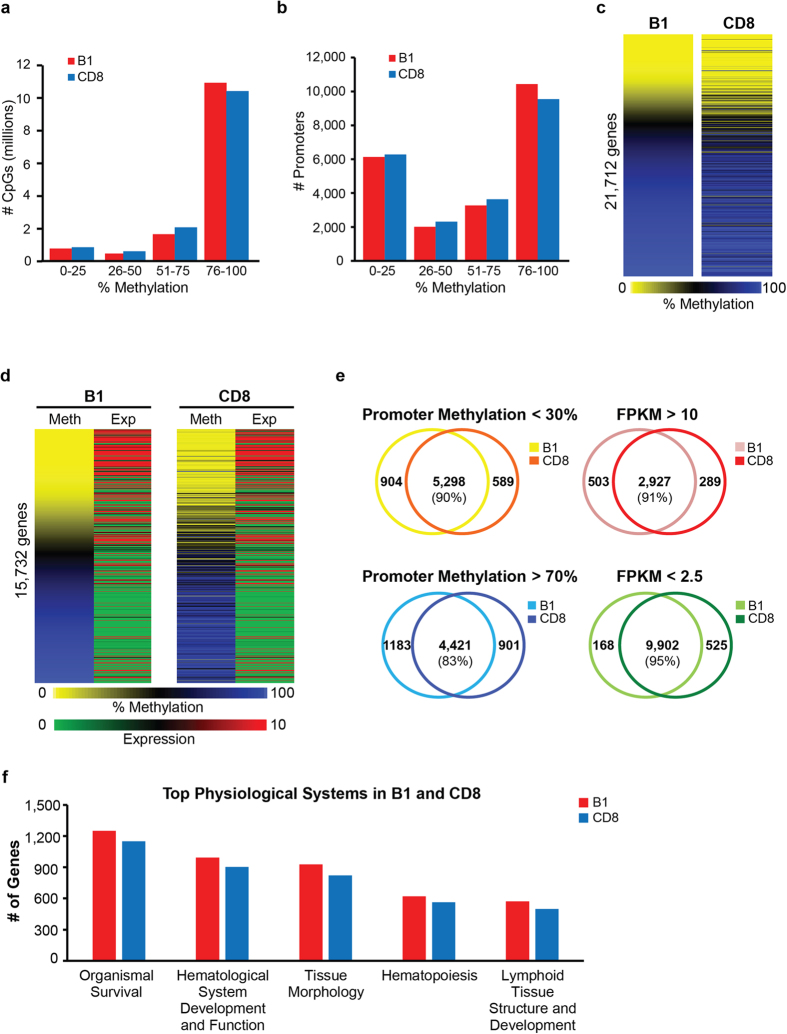
Transcriptome and methylome of normal B-1a and CD8 cells.(a) Breakdown of CpG methylation as determined by WGBS in B-1a (B1) and CD8 samples. Individual CpGs were placed into 4 categories based on percent methylation (0–25%, 26–50%, 51–75%, and 76–100%). (b) Breakdown of promoter methylation for 21,712 genes in B1 and CD8 samples. Methylation percentage for individual CpGs were annotated to the core promoter regions (−300 bp to +150 bp relative to the TSS). Methylation percentages for all CpGs across the 450 bp region were averaged to give a mean methylation value for each gene promoter. Promoters were placed in 4 categories based on percent methylation (0–25%, 26–50%, 51–75%, and 76–100%). (c) Methylation status of 21,712 promoters in B1 and CD8 samples as determined by WGBS. Mean promoter methylation was determined as described in part b of the figure legend. Hypomethylation is shown in yellow and hypermethylation in blue. (d) Heat map presentation of promoter methylation (analyzed as in Fig. 2b) and corresponding gene expression (presented as average FPKM values as determined by RNA-seq) in mouse splenic B1 and CD8 cells for 15,732 genes. Genes with high FPKM values are shown in red and genes with low FPKM values are shown in green. Heat maps are organized in the same gene order to match data for methylation and gene expression. (e) (left) Venn diagram showing number of unique and overlapping hypomethylated (methylation <30%) and hypermethylated (methylation >70%) promoters in B1 and CD8 samples. (right) Venn diagram showing number of unique and overlapping highly expressed (FPKM > 10) and lowly expressed (FPKM <2.5) genes in B1 and CD8 samples. (f) Ingenuity Pathway analysis (IPA) of highly expressed genes (FPKM ≥10) in B1 (red) and CD8 (blue) samples. The top subcategories obtained in Physiological System, Development and Functions are displayed (P < 0.05, for all subcategories).